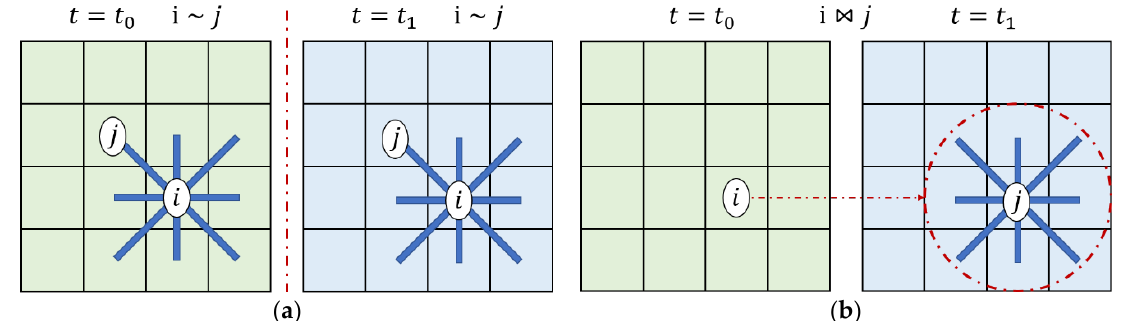
Figure 6. Graphical representation of the two different local neighborhoods used within the proposed energy function: ( a ) local neighborhood corresponding to the notation 𝑖 ∼ 𝑗 ; ( b ) local neighborhood corresponding to the notation 𝑖 ⋈ 𝑗 .